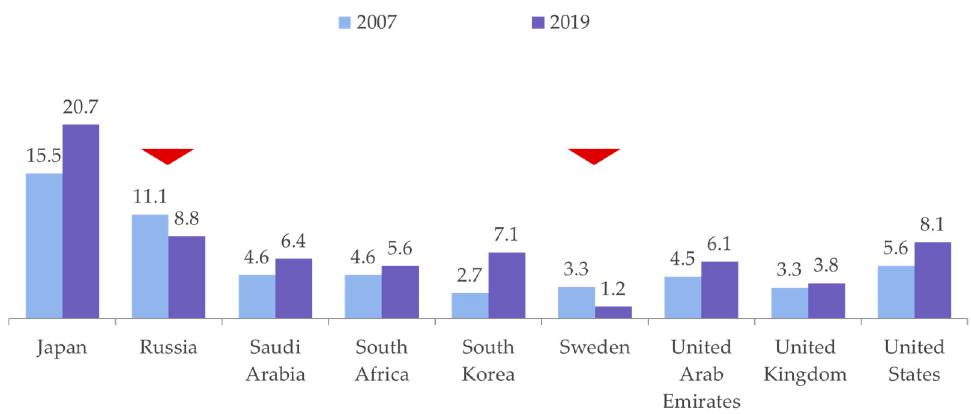
Figure 4. Currency-in-circulation as a percentage of GDP in nine emerging and advanced economies, 2007 and 2019. M0 is defined as currency-in-circulation outside banks, though the US Federal Reserve includes in its definition vault money, held by banks to meet the immediate cash needs of clients. All data are drawn from the respective central bank of each country. The first data point for the UAE relates to 2010 in the absence of older data.